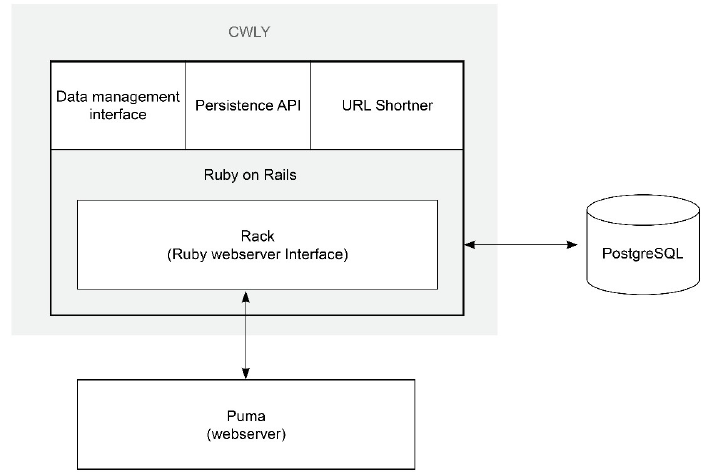
Figure 7. CWLY application components. Source: adapted from [10].